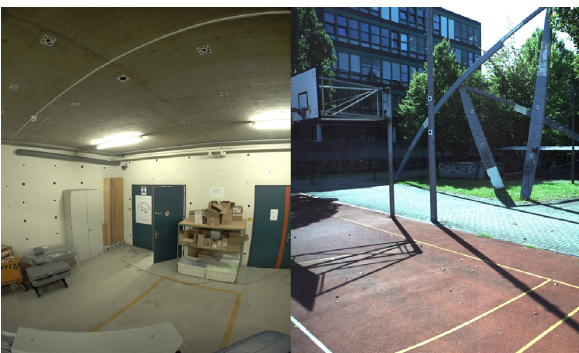
Figure 5. Calibration fields (left: indoor, right: